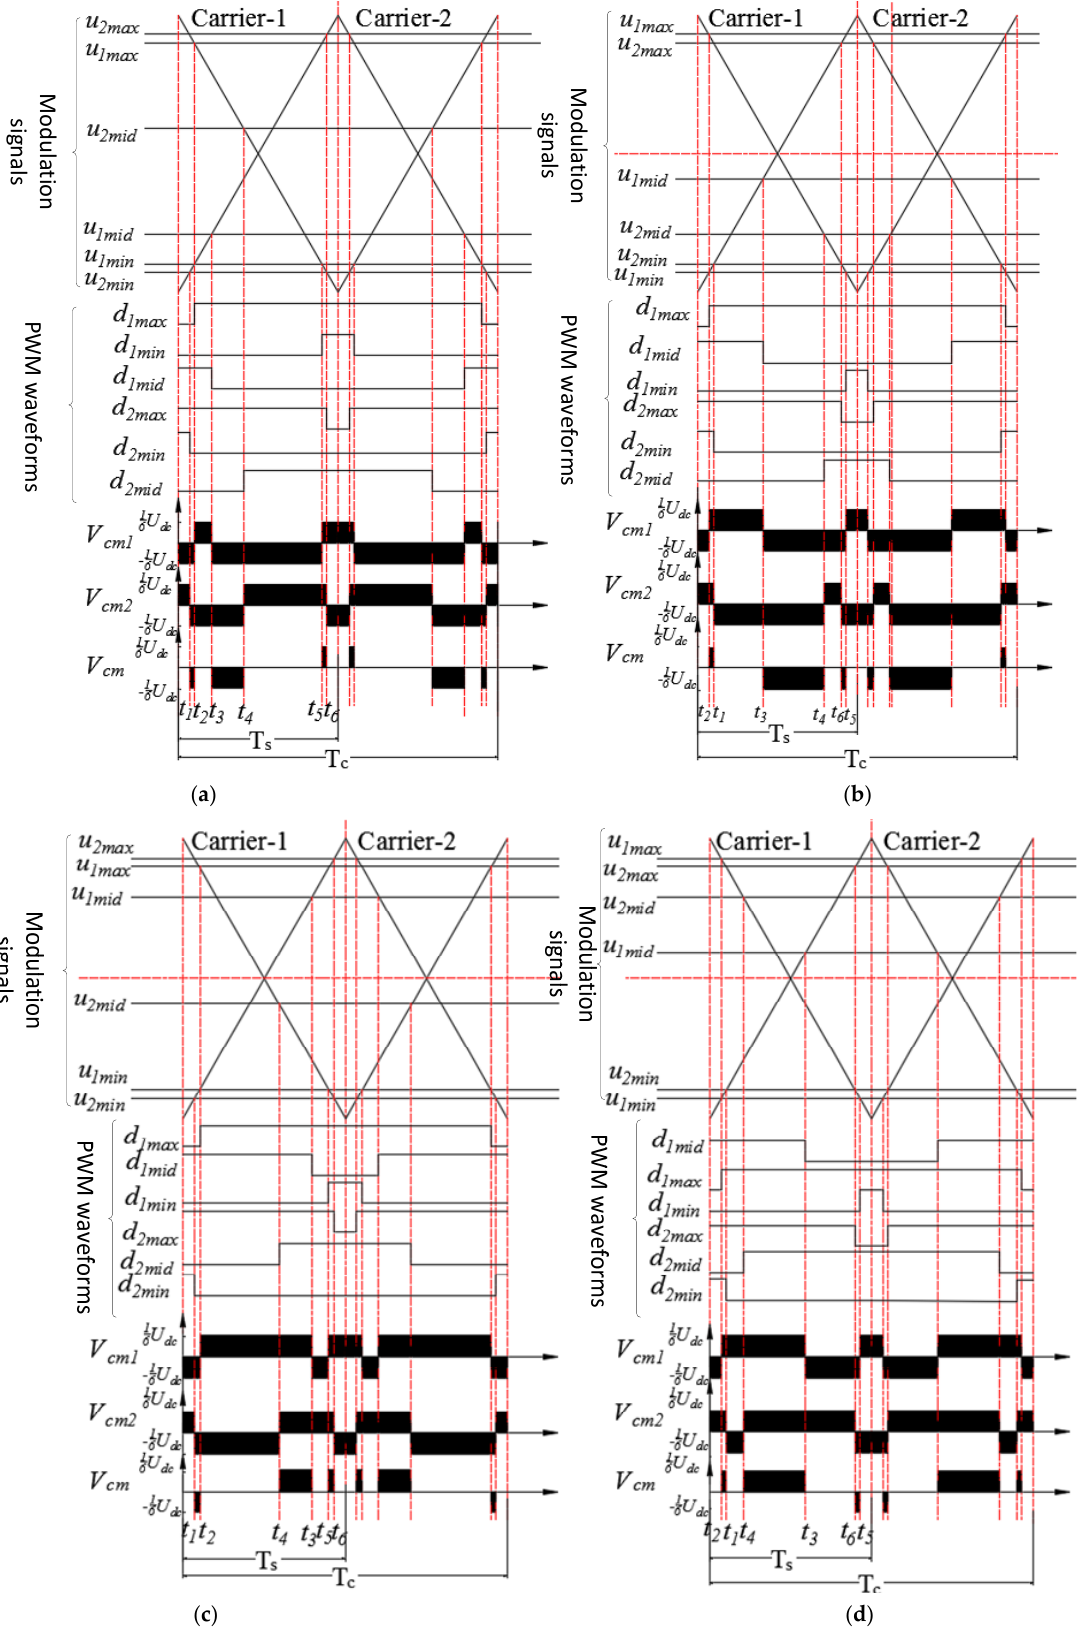
Figure 4. Four types of schemes in the DZICMV: ( top ) modulation signals and carriers, ( middle ) PWM waveforms, ( bottom ) two sub-CMVs and total CMV for ( a ) Type I; ( b ) Type II; ( c ) Type III; ( d ) Type IV. Table 4. Relationship between sectors and the four types of schemes in the DZICMV.